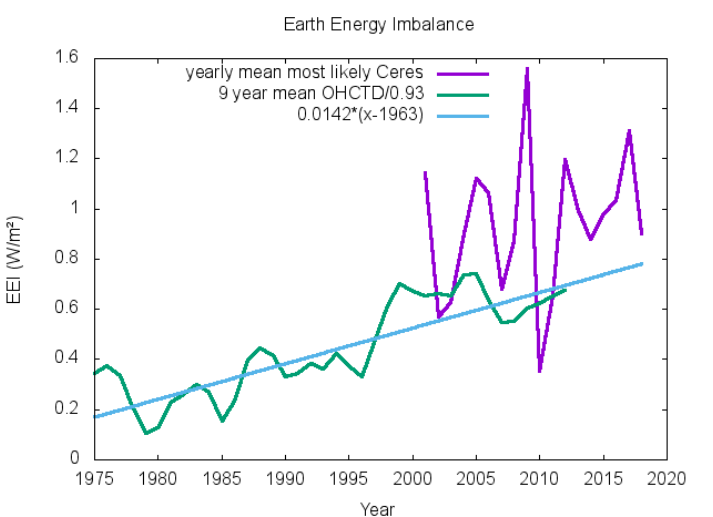
Figure 2. Comparison of independent estimates of EEI variations. Purple curve: most likely estimate of EEI from Ceres. Green curve: 9 year running mean EEI derived from OHCTD. Blue line: linear fit to green